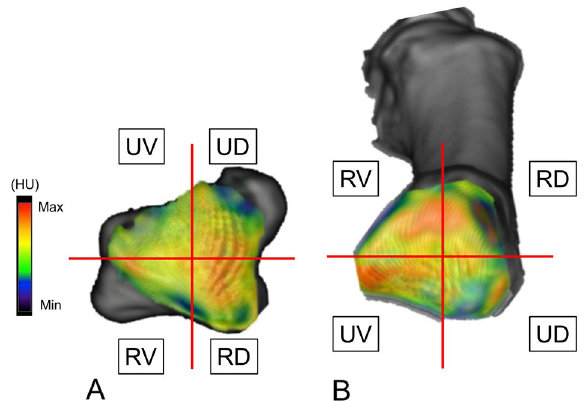
Figure 3. The image shows regions using quantitative analysis of bone density mapping data in the TMC joint of the right hand. ( A ) the articular surface of the trapezium. ( B ) the articular surface of the first metacarpal. RD radial-dorsal, RV radial-volar, UD ulnar-dorsal, UV ulnar-volar.